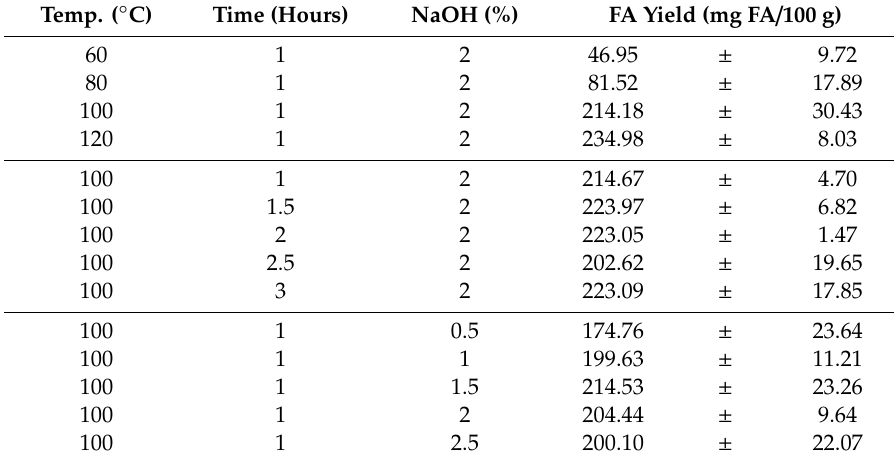
Table 3. Conditions and results obtained for optimization of the parameters for alkaline hydrolysis reaction in Ace pressure tubes. FA yield is expressed as mg of FA per 100 g of brewer’s spent grain (BSG).